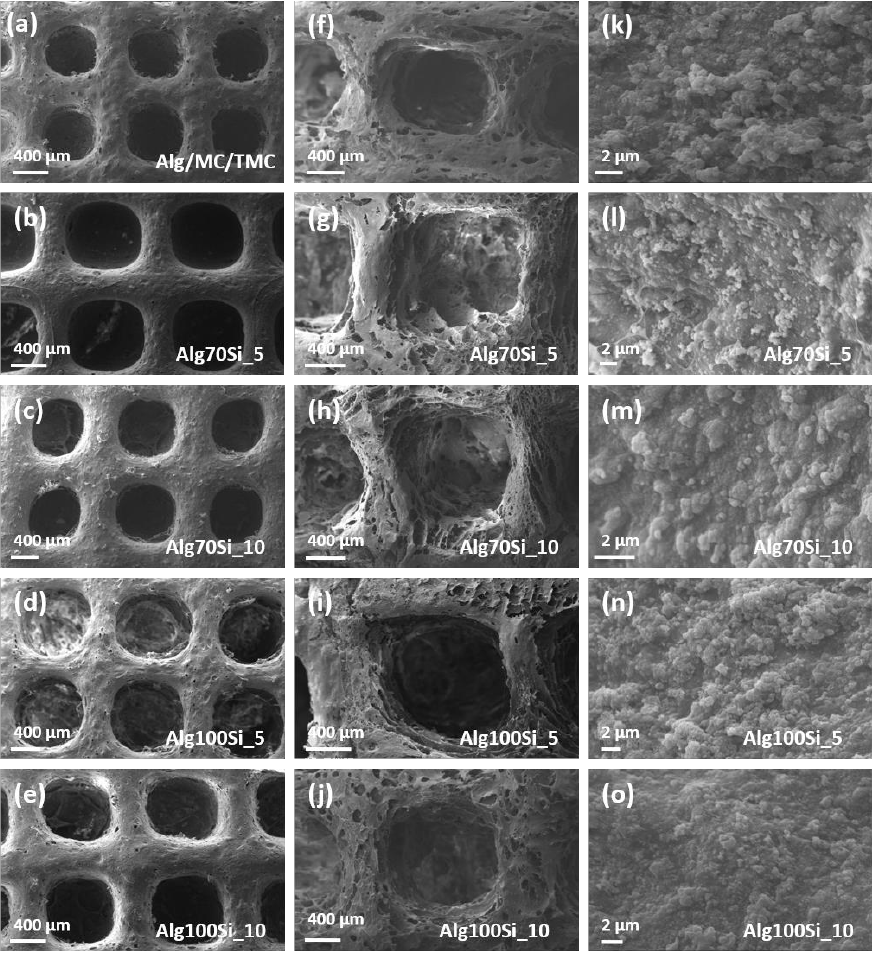
Figure 6. SEM images of samples before ( a – e ) and after ( f – o ) immersion in 2xSBF solution for 2 weeks.